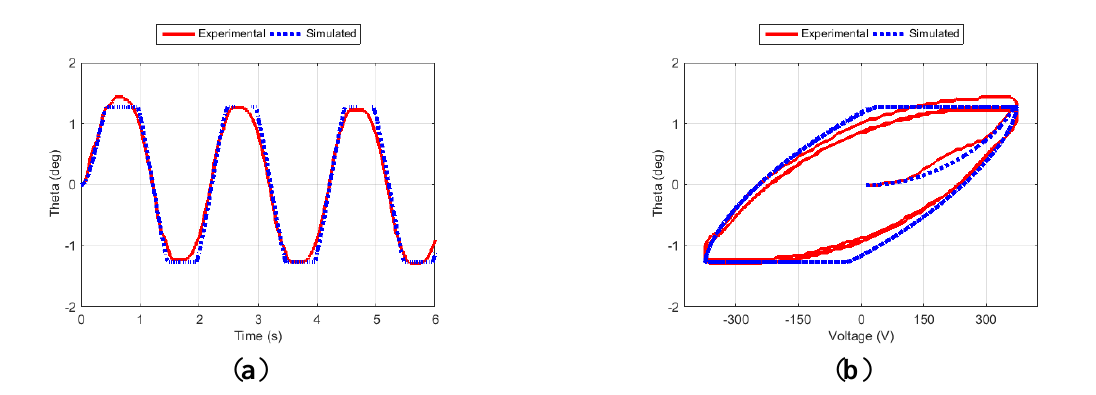
Figure 10. Fin angle ( a ) and hysteresis curve ( b ) for Case 2.